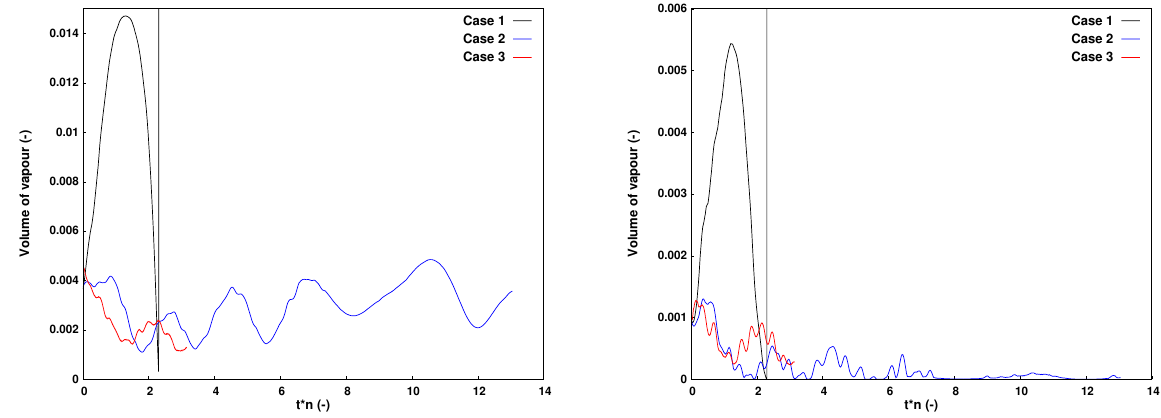
Figure 4. Time-history of the efficiency, the dimensionless volume of vapour, the torque factor T ED (measured value: 0.127) and the speed factor n ED (measured value: 0.288).